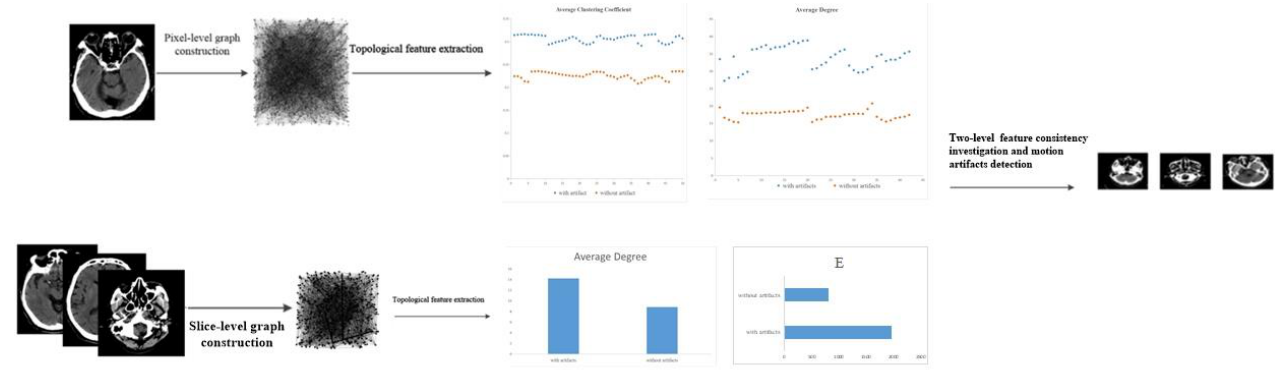
Figure 3. Pipeline of Motion Artifacts Detection Method based on topological properties.